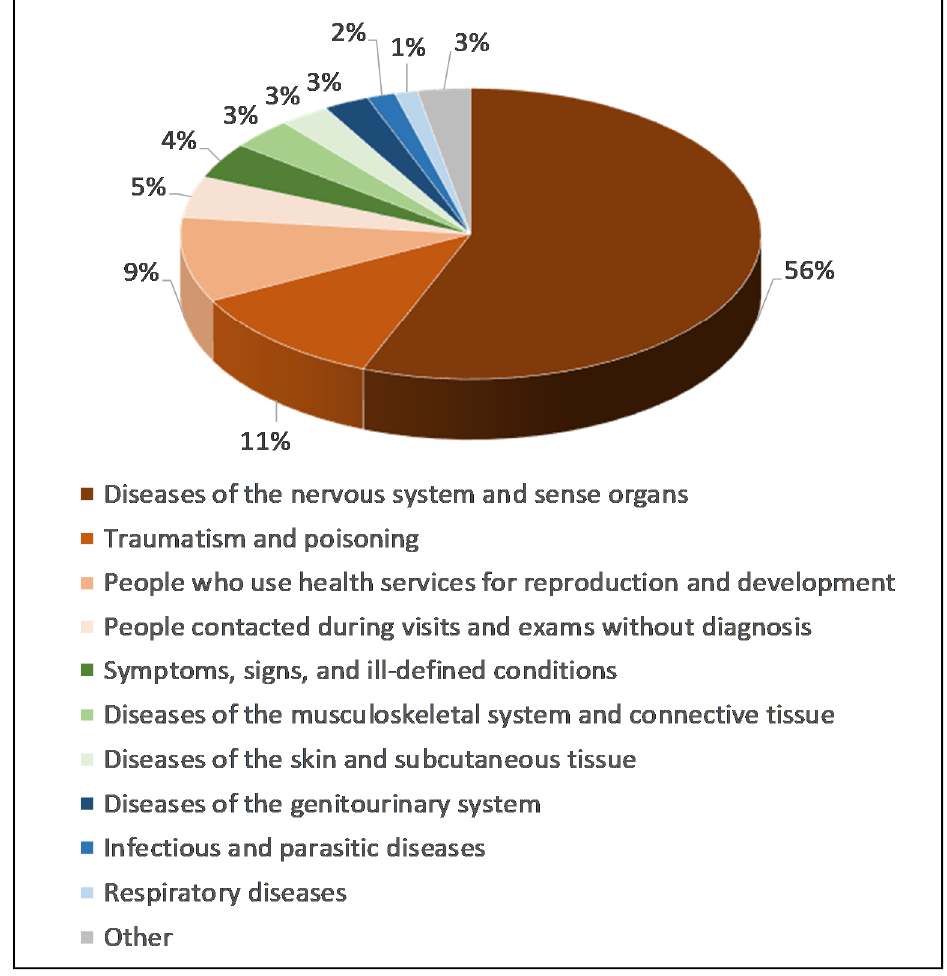
Figure 1. Accesses by cause in code white recorded in 2011 by the Policlinico Umberto I emergency room. Source: authors’ elaboration.